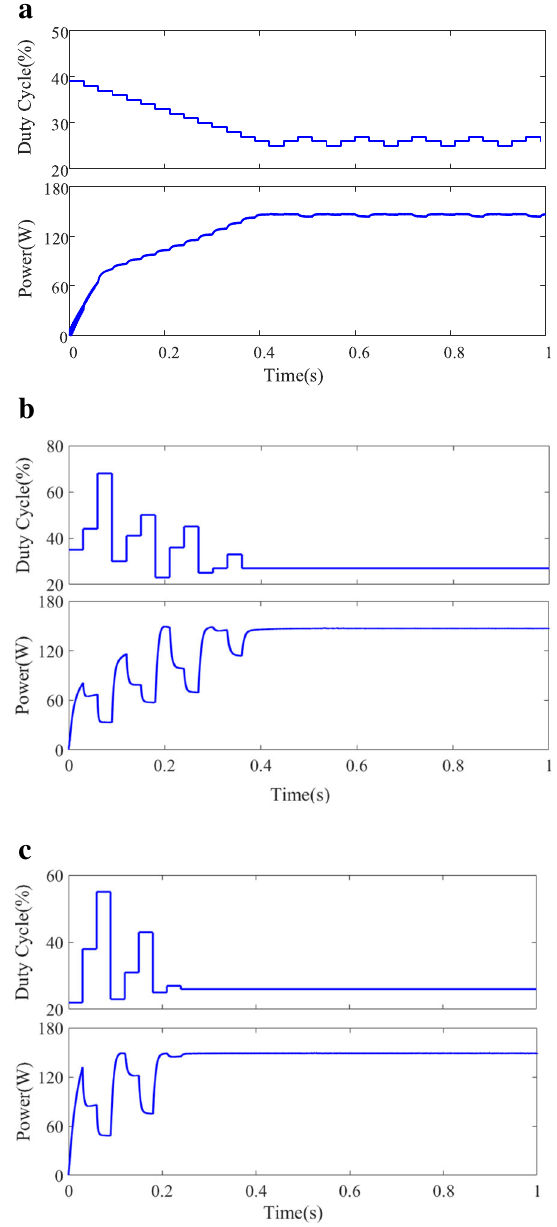
Fig. 5 Simulation results of the three methods for start-up test. a P&O. b PSO and ( c ) proposed algorithm